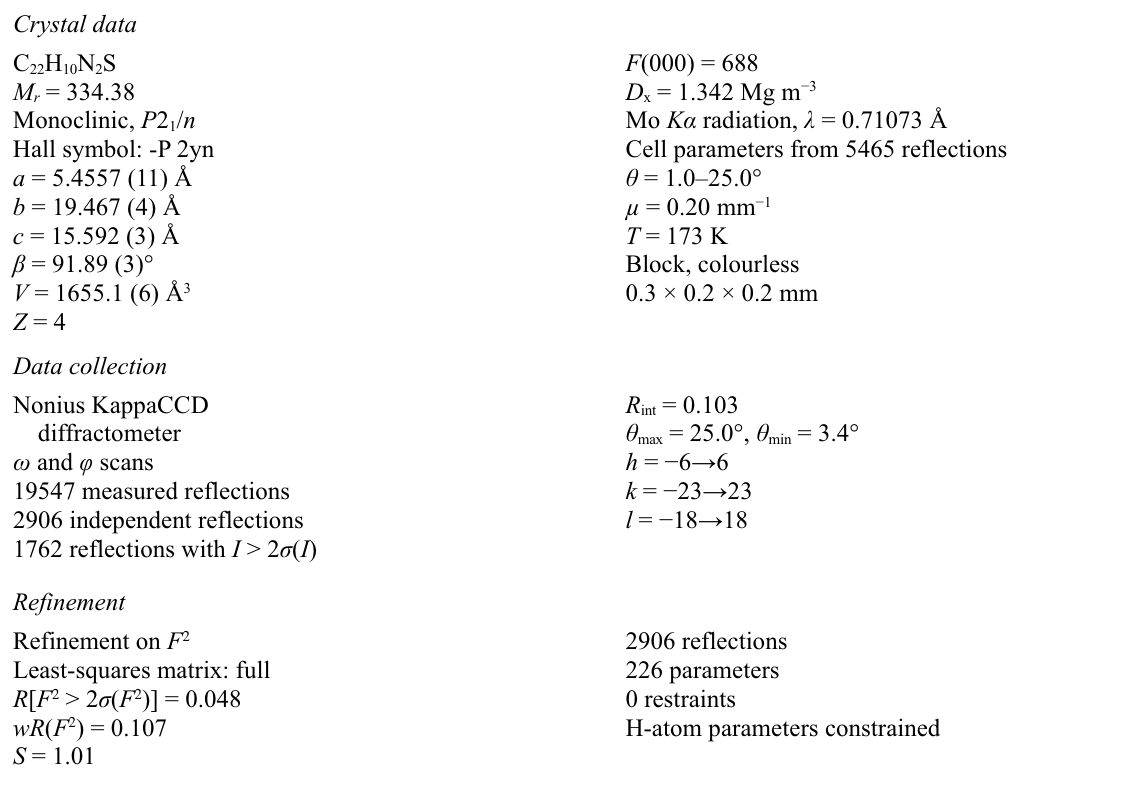
Figure 3 An alternate view of the packing of (I), showing the close C—H···N contacts (less that 0.1 Å + sum of vDW radii). 4,4 ′